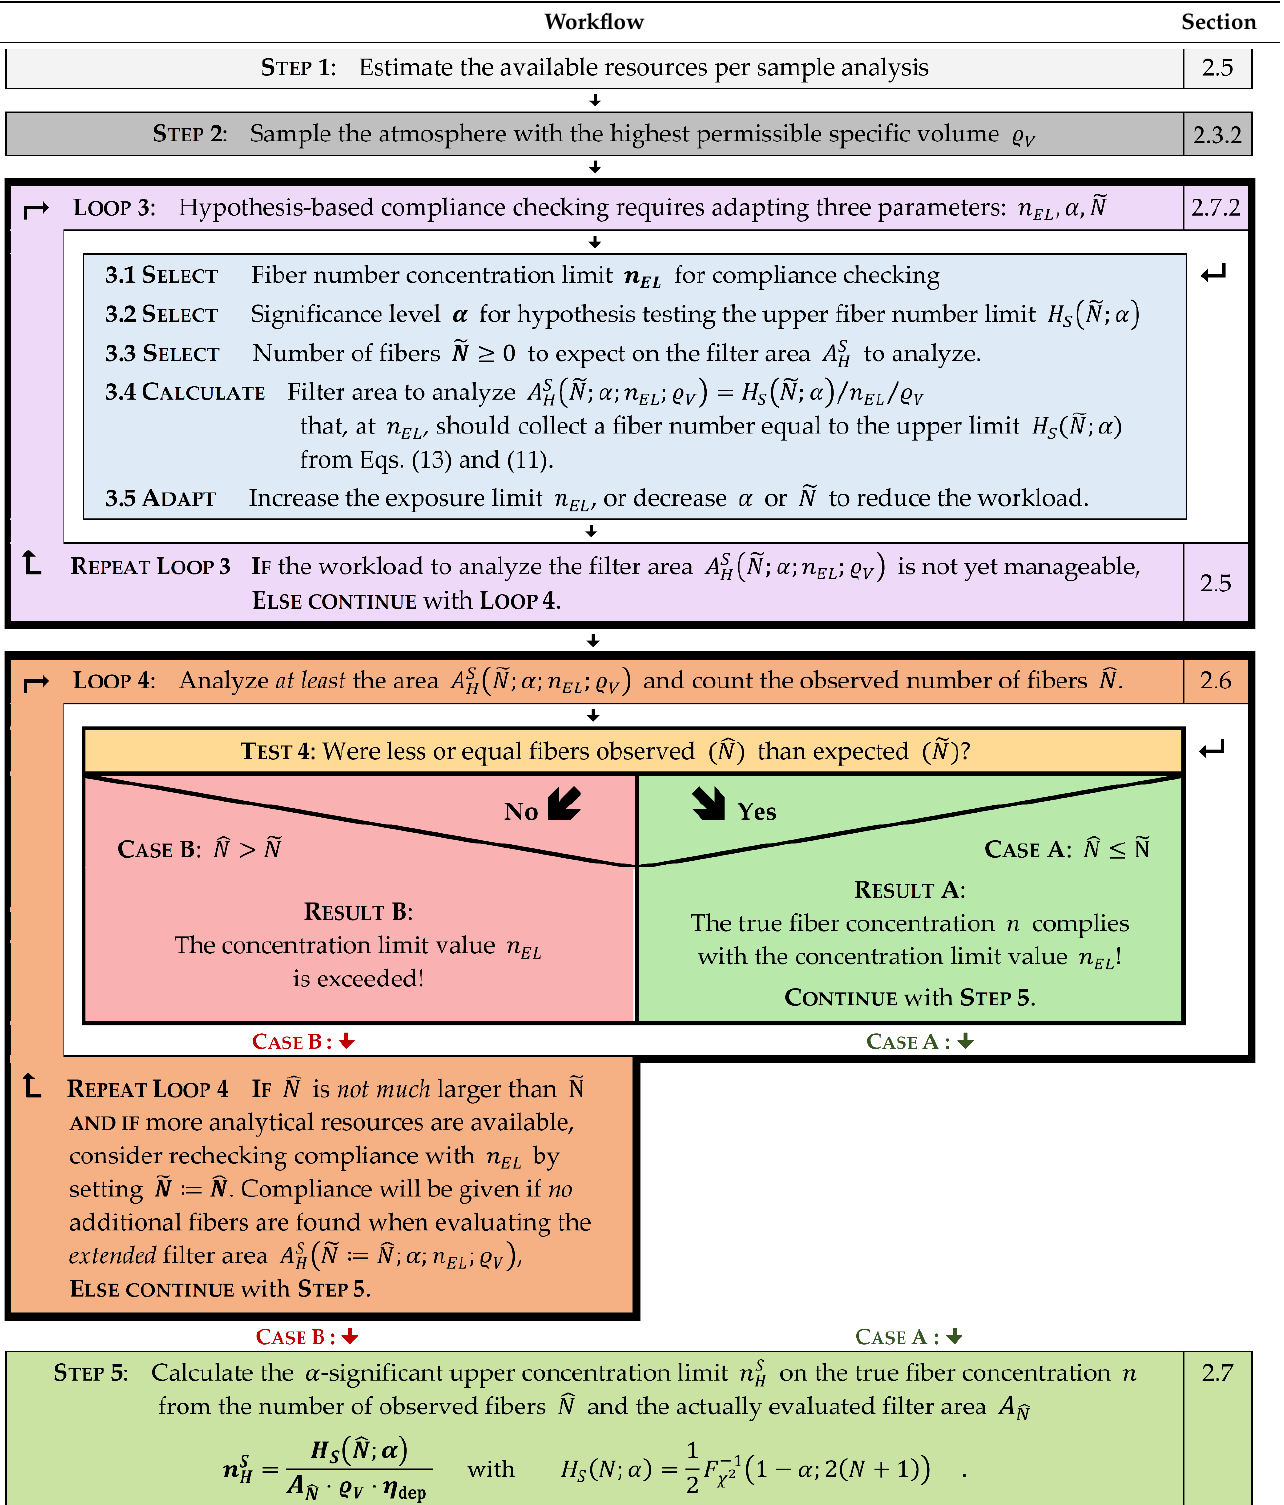
Table 11. Data evaluation workflow schematized as Nassi-Shneiderman-like diagram.